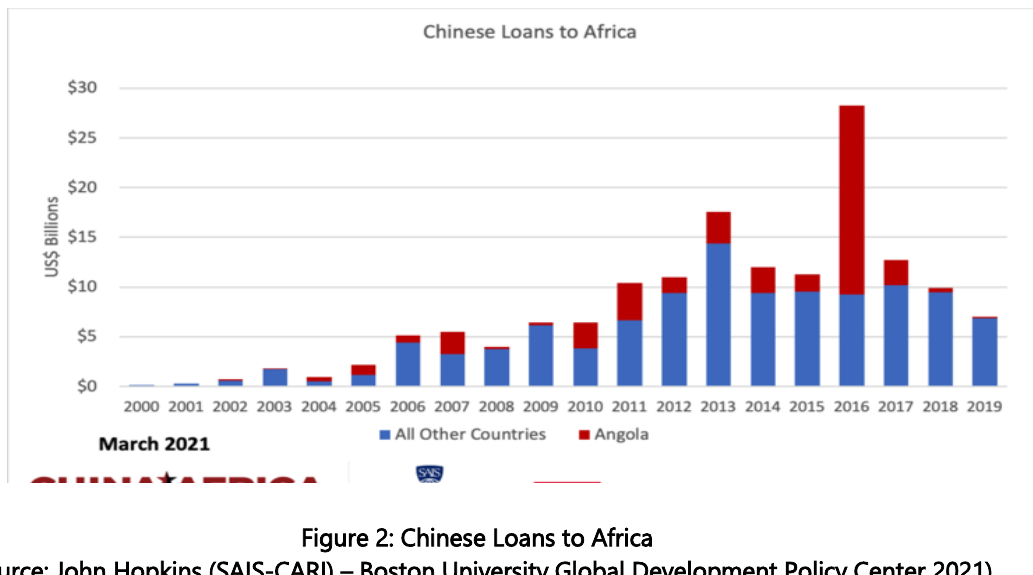
Figure 2: Chinese Loans to Africa